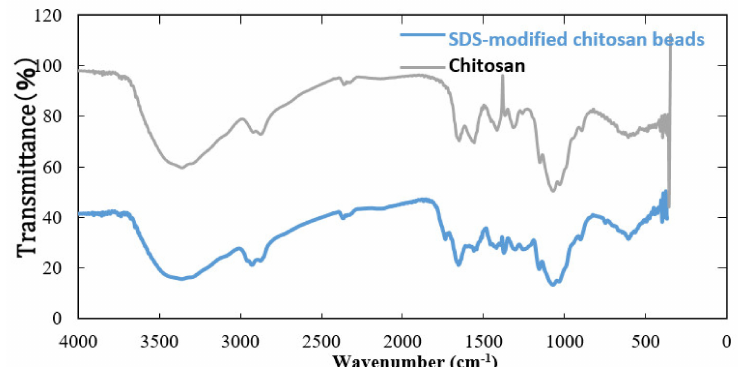
Figure 9. Fourier transform-infrared spectroscopy (FT-IR) spectra of chitosan and SDS-modified chitosan beads.